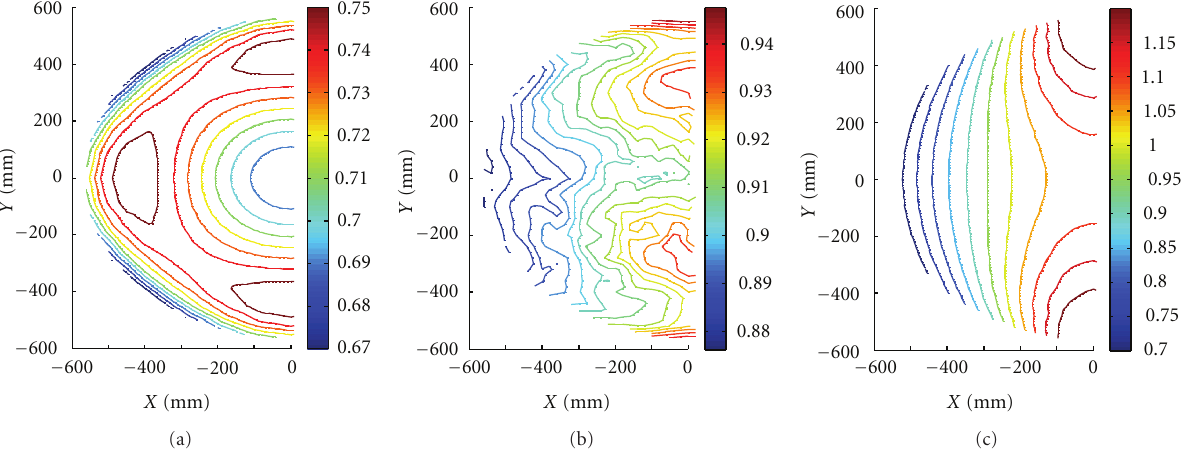
Figure 17: Manipulability index μ t (a), normalized velocity along the X direction (b), and DSI μ X computed in the horizontal half-plane XY with Z = − 900 mm (c).